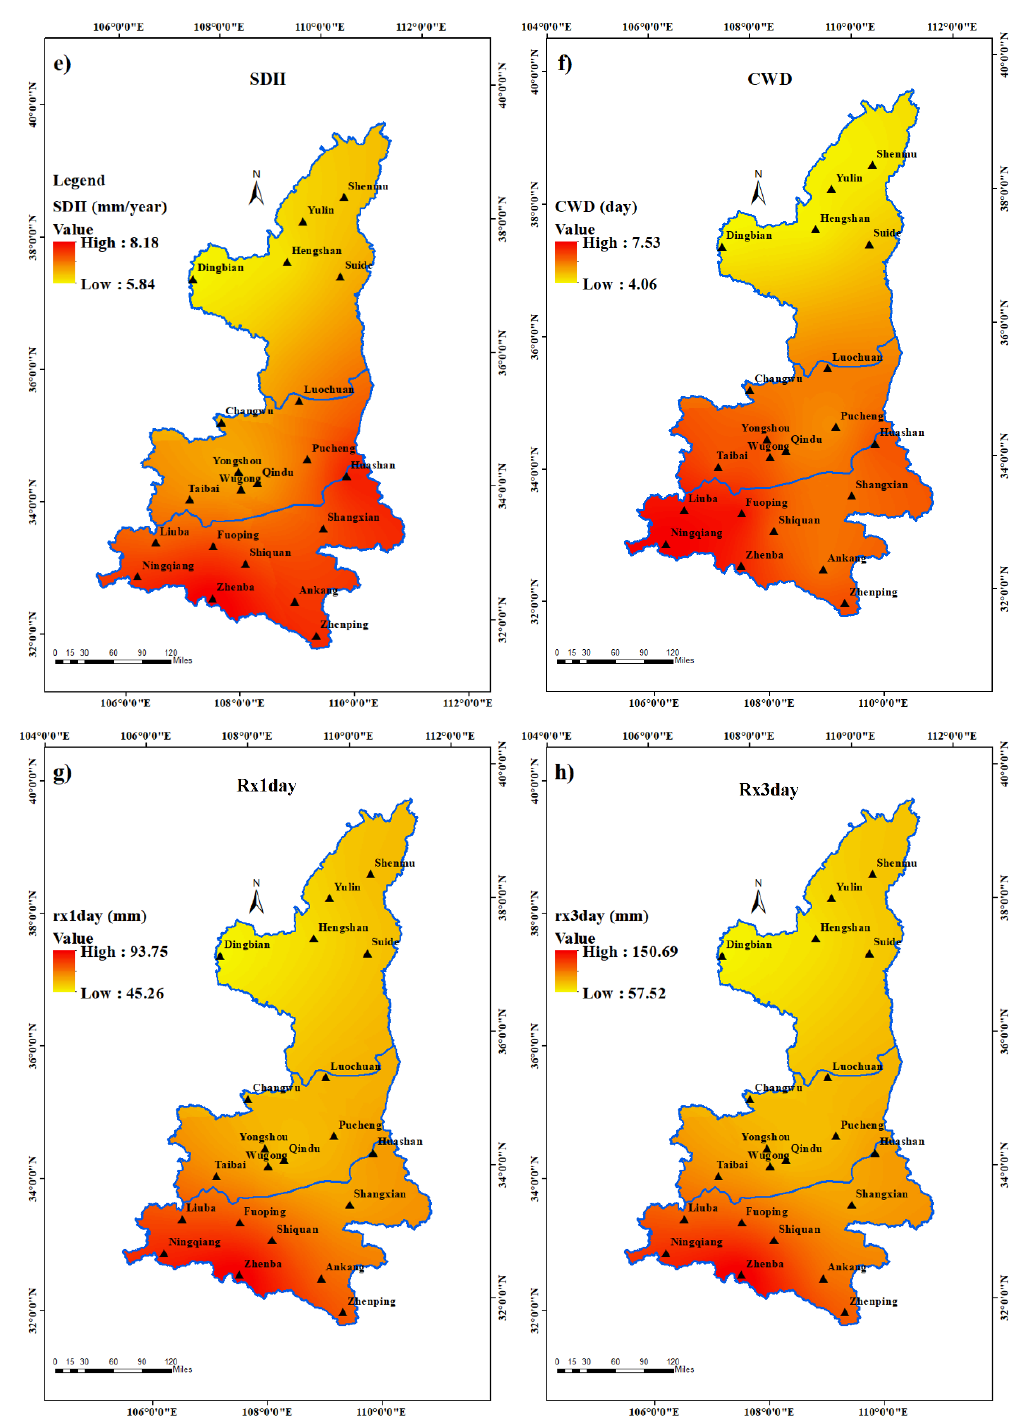
Figure 3. Spatial distribution of ( a ) PRCPTOT, ( b ) wet days, ( c ) R25, ( d ) R50 and ( e ) SDII, ( f ) CWD, ( g ) Rx1day, ( h ) Rx3day.